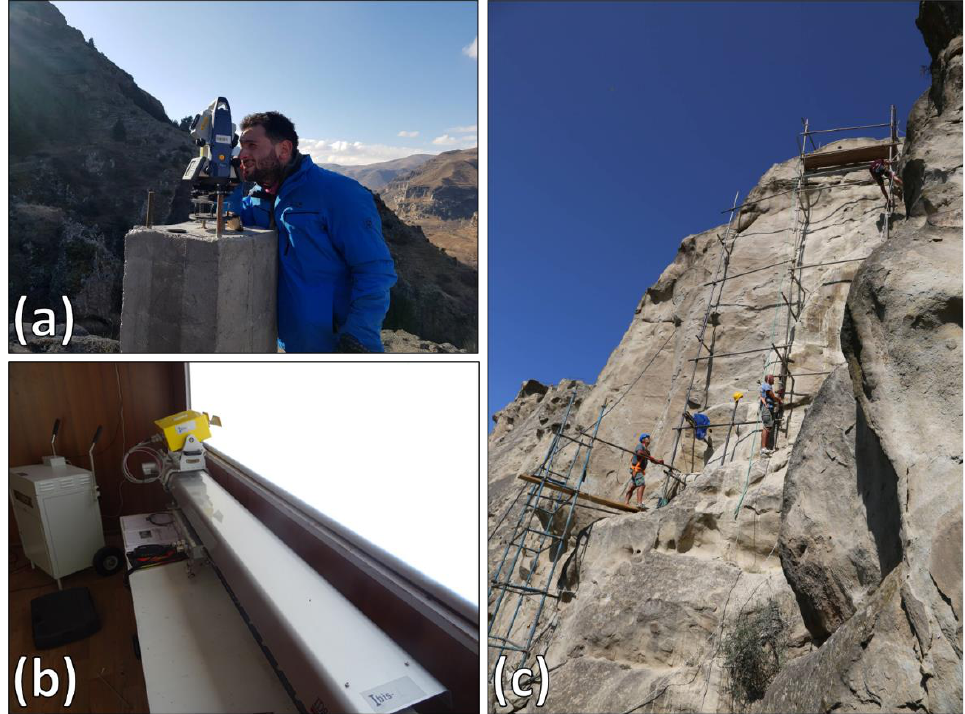
Figure 19. Nonstructural measures, such as displacement monitoring systems, planned in David Gareja: Robotized Total Station ( a ); ground based interferometric synthetic aperture radar system ( b ). The scaffolding constructed for the anchoring phase in Uplistsikhe ( c ) .